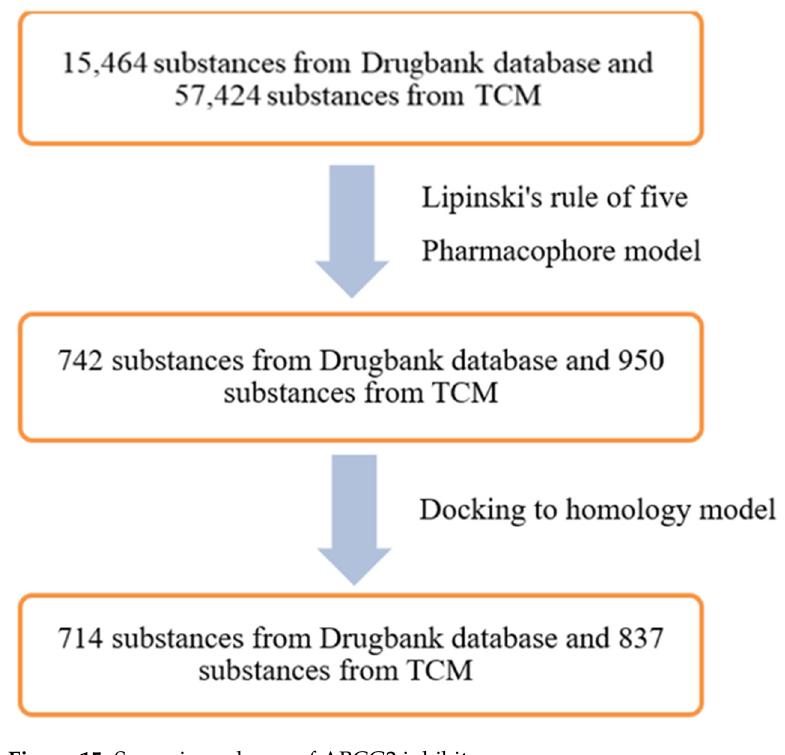
Figure 15. Screening scheme of ABCG2 Figure 15 . Screening scheme of ABCG2 inhibitors .